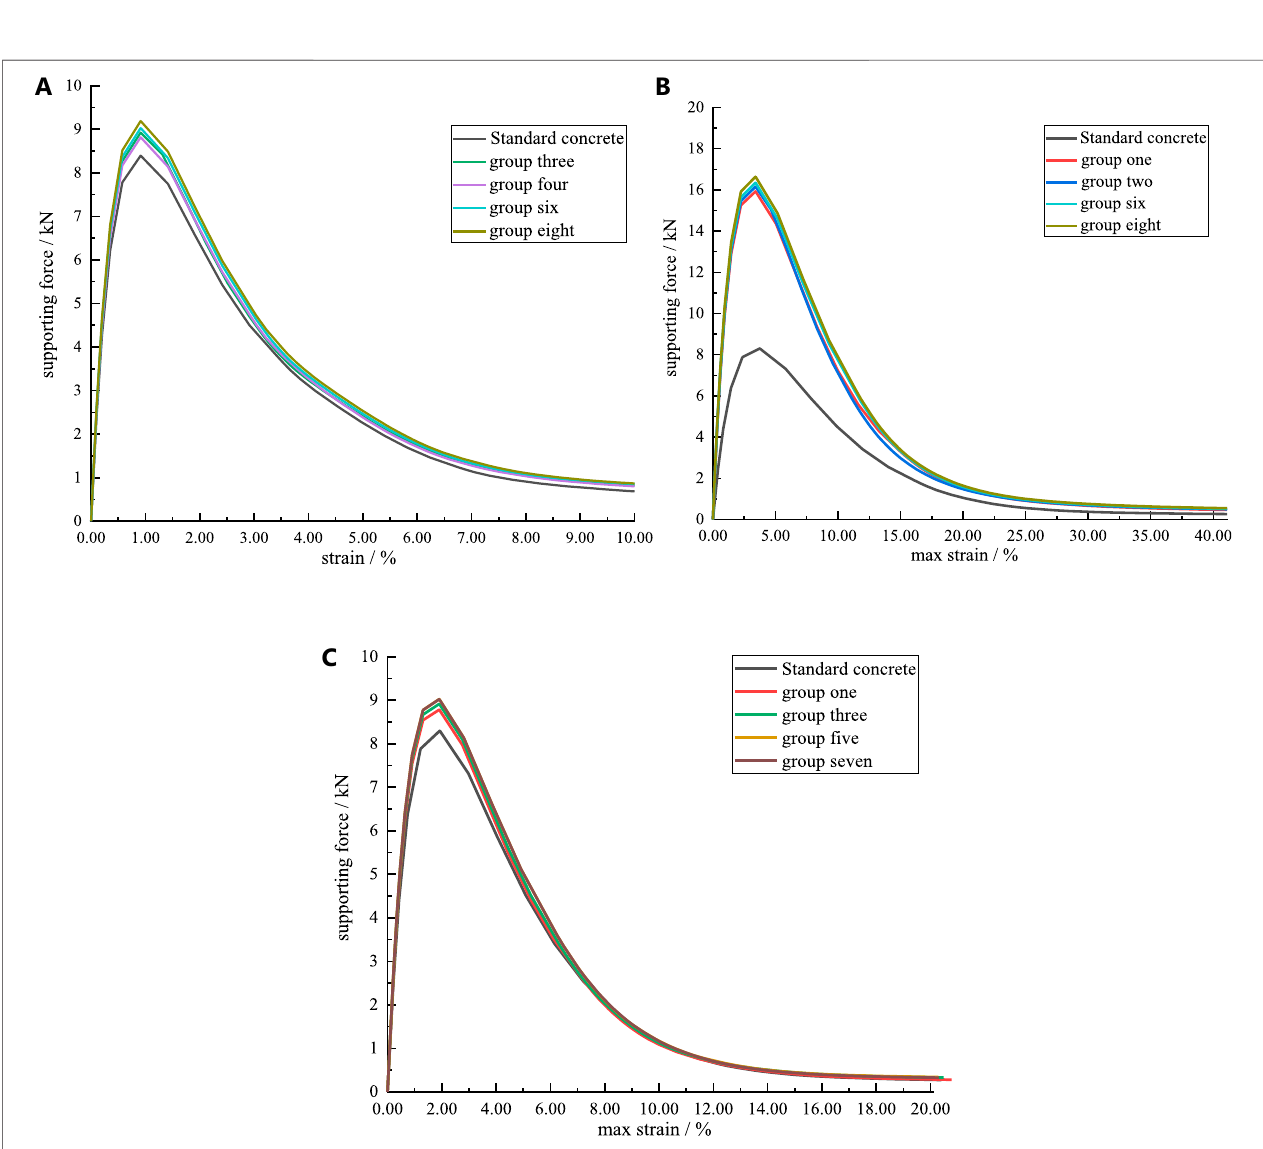
FIGURE 12 | Comparison of deformation resistance curves of steel fi ber concrete specimens and standard specimens: (A) support force and strain curve of test block under uniform tension; (B) support force versus strain curves of test blocks under equivalent non-uniform tension in the feature-1 area; (C) support force versus strain curves of test blocks under equivalent non-uniform tension in feature-2